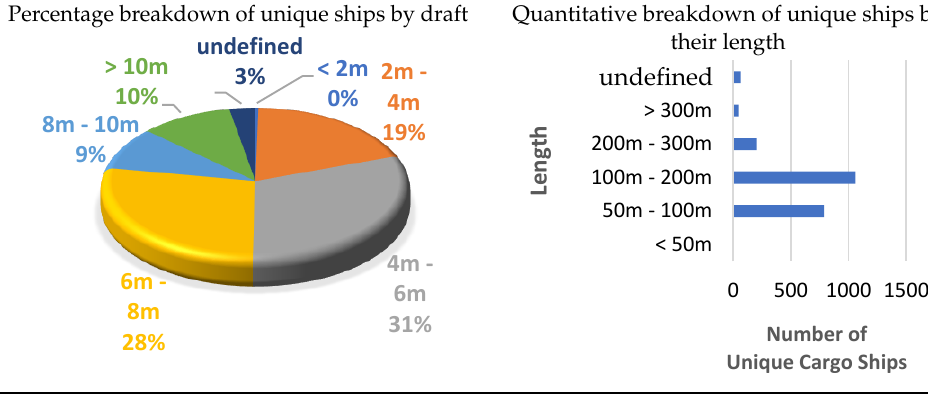
Table 7. Qualitative characteristics of cargo vessels.